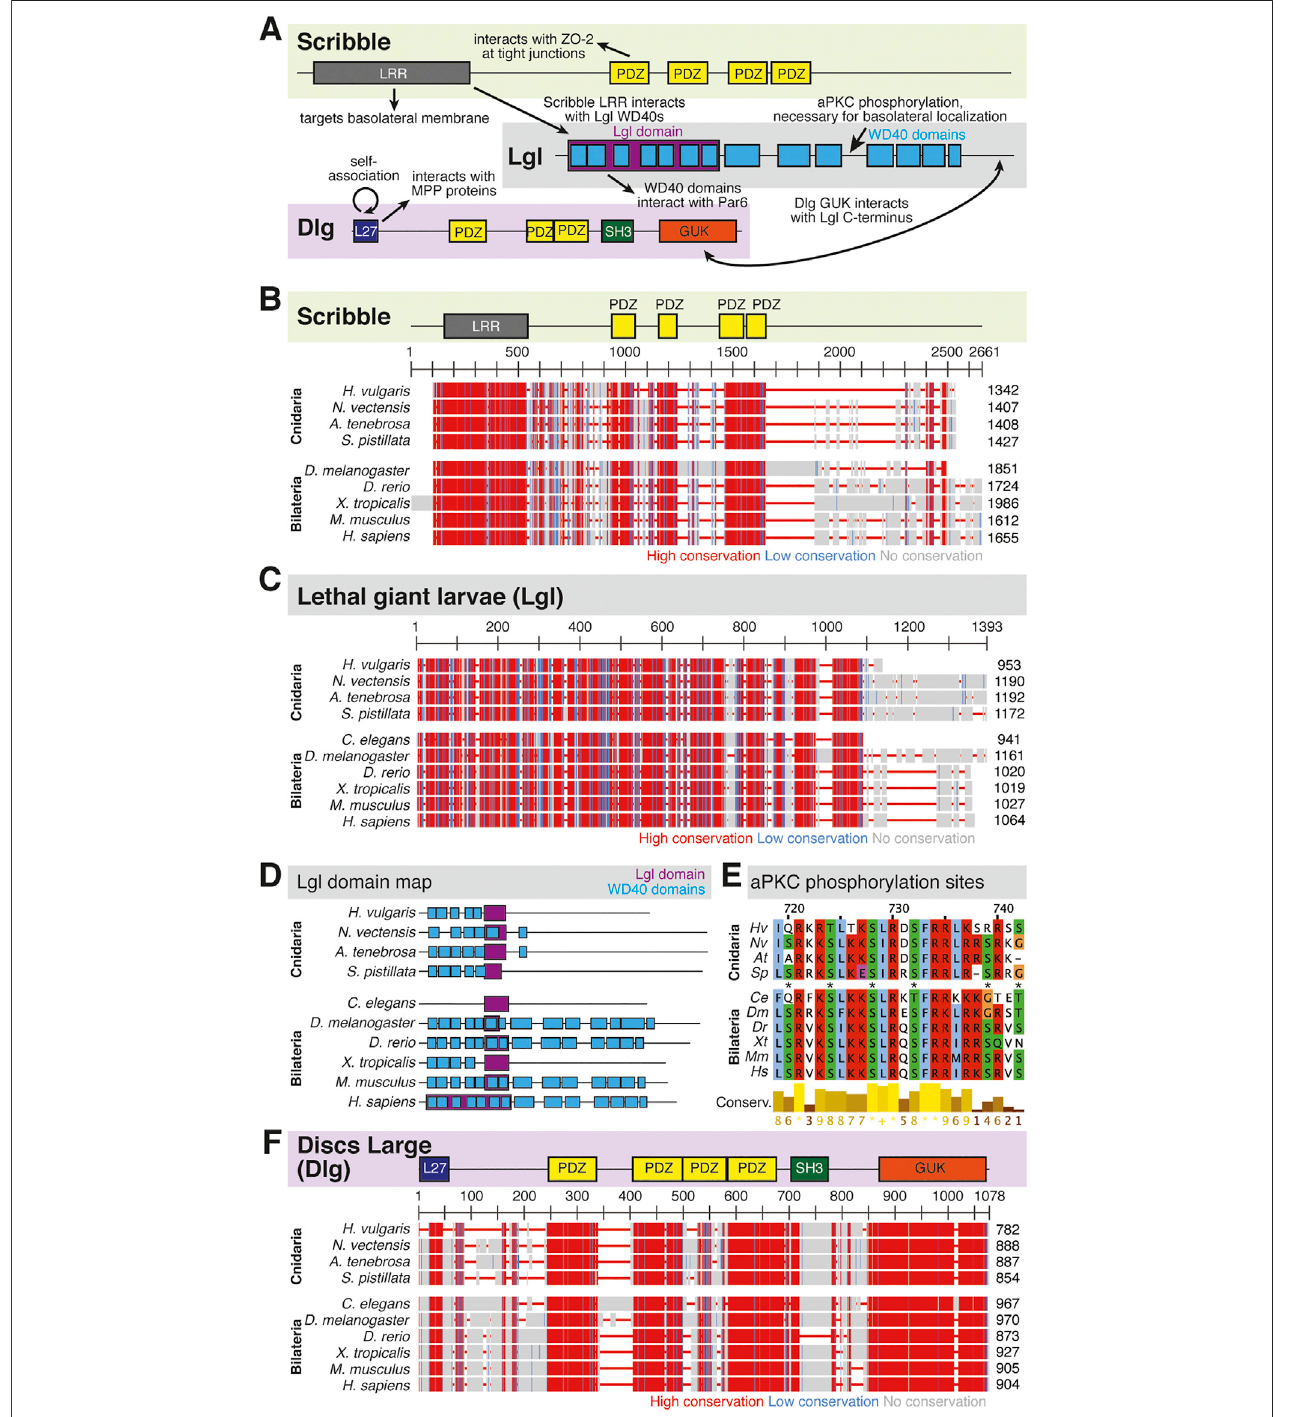
FIGURE 5 | The Scribble complex de fi nes the basolateral domain and is conserved across bilaterians and cnidarians. (A) Representation of the human Scribble complex with Scribble, Discs Large (Dlg), and Lethal Giant Larvae (Lgl) pictured. Functional domains and examples of protein-protein interactions denoted. (B,C) Full protein alignments of Scribble (B) and Lethal Giant Larvae (Lgl, C). Scribble functional domains depicted in their respective positions within alignment. (D) Lgl domains maps depicting WD40 (cyan) and Lgl (violet) positions. Protein lengths drawn to scale. (E) Amino acid alignment of Lgl region phosphorylated by aPKC. Critical residues depicted with asterisks. (F) Full protein alignment of Discs Large (Dlg). functional domains depicted in their respective positions within alignment. For all alignments: COBALT used for all protein alignments. High (red), low (blue), and no conservation (gray) regions denoted. FASTA sequences from COBALT visualized